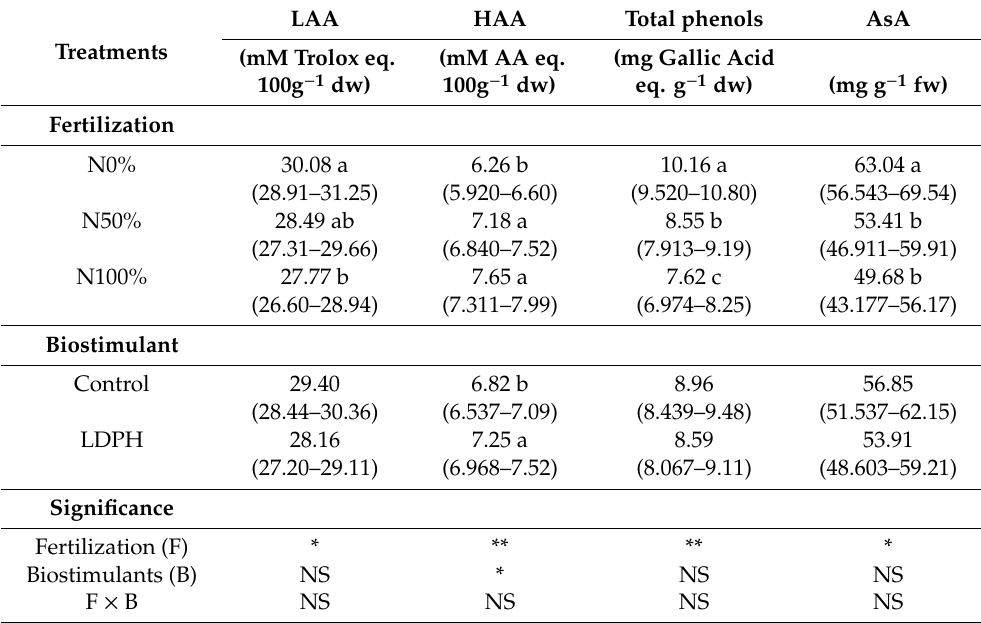
Table 6. Lipophilic (LAA) and hydrophilic (HAA) antioxidant activity, total phenols and ascorbic acid (AsA) of lamb’s lettuce plants as a ff ected by nitrogen (N) fertilization levels (0, 2.5 and 5.0 g N m − 2 ; N0%, N50%, N100%, respectively) and biostimulant applications (control and LDPH: Legume-derived protein